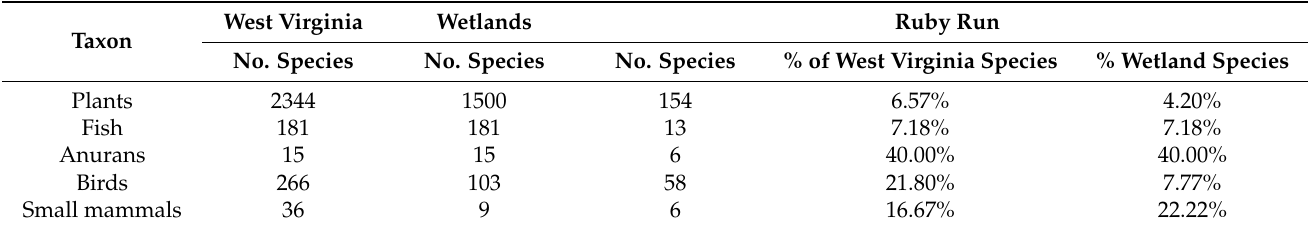
Table 10. Number of species by taxa within West Virginia, number of species by taxa that are wetland/aquatic dependent, number of species documented in Ruby Run (this study), and the percent of species we documented compared to the total number in West Virginia and the percent of species we documented compared to the total number that are wetland-dependent